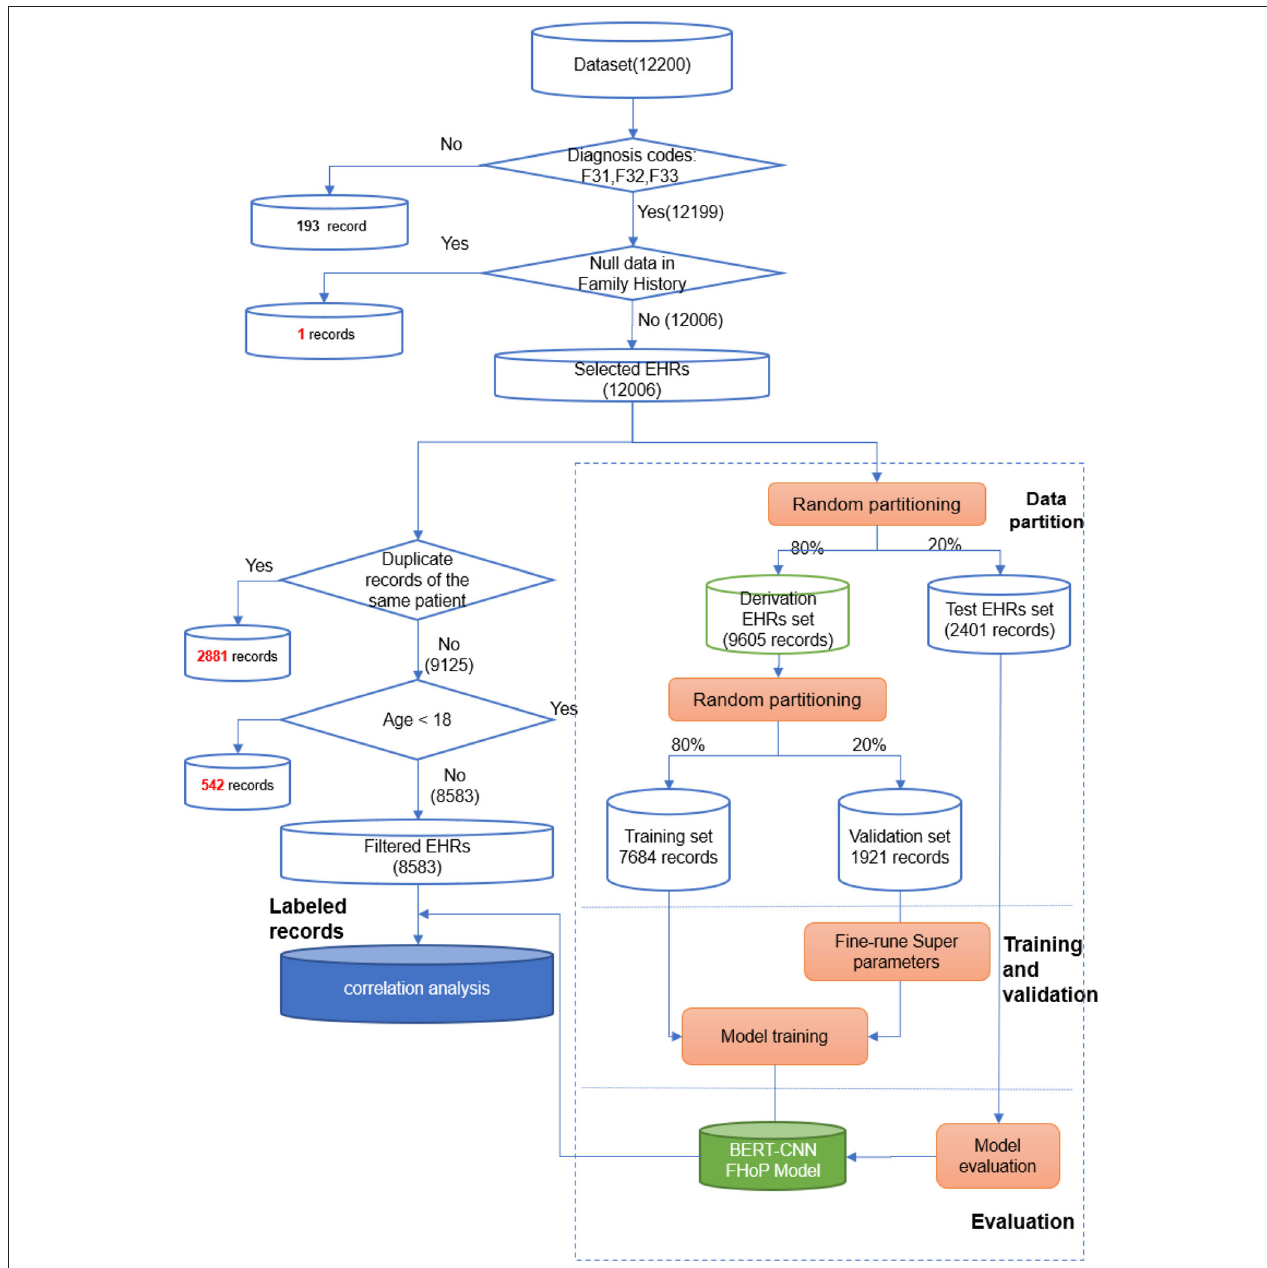
FIGURE 1 | The research